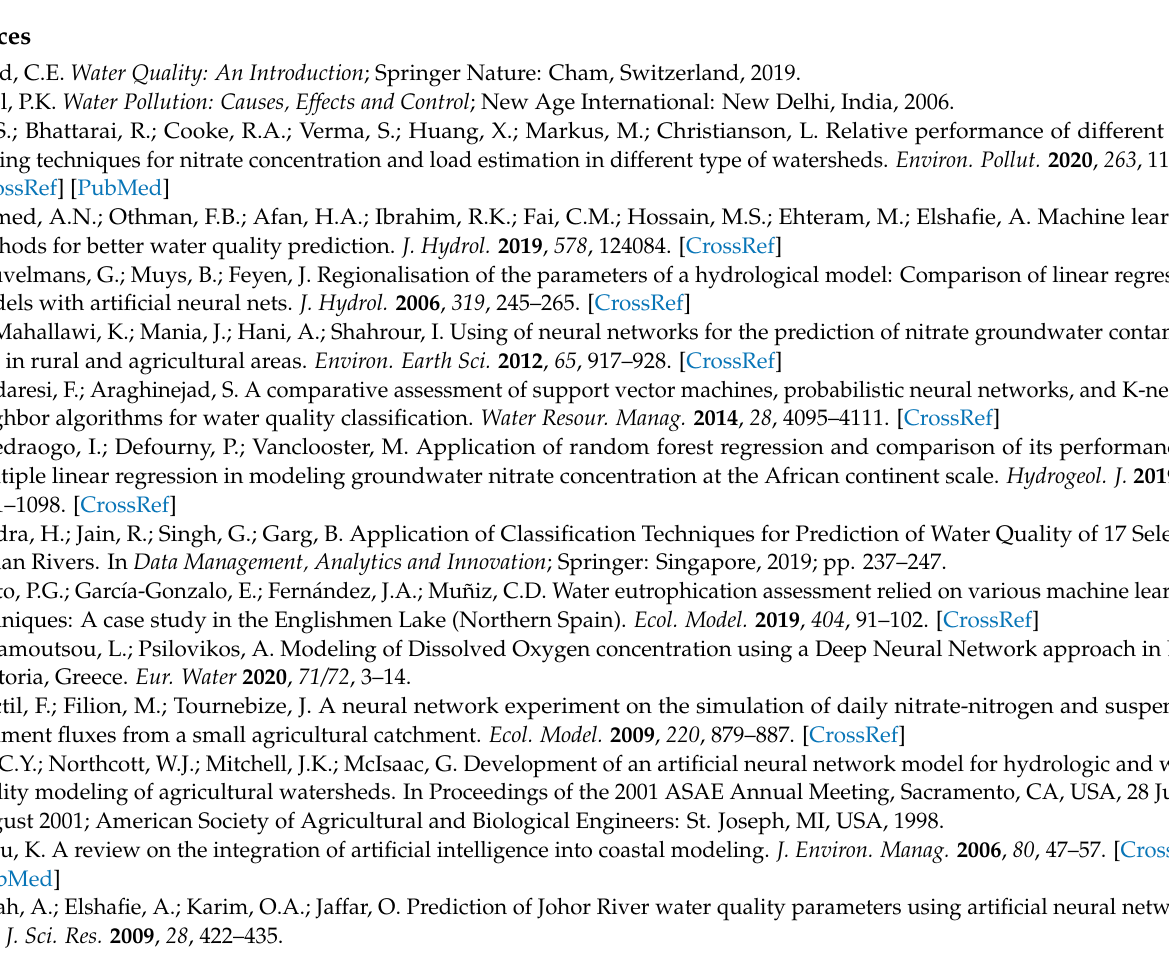
concentration, Table S4: Hyperparameters and search spaces of Regression Tree (RT), Ensemble, and Gaussian Process Regression (GPR)